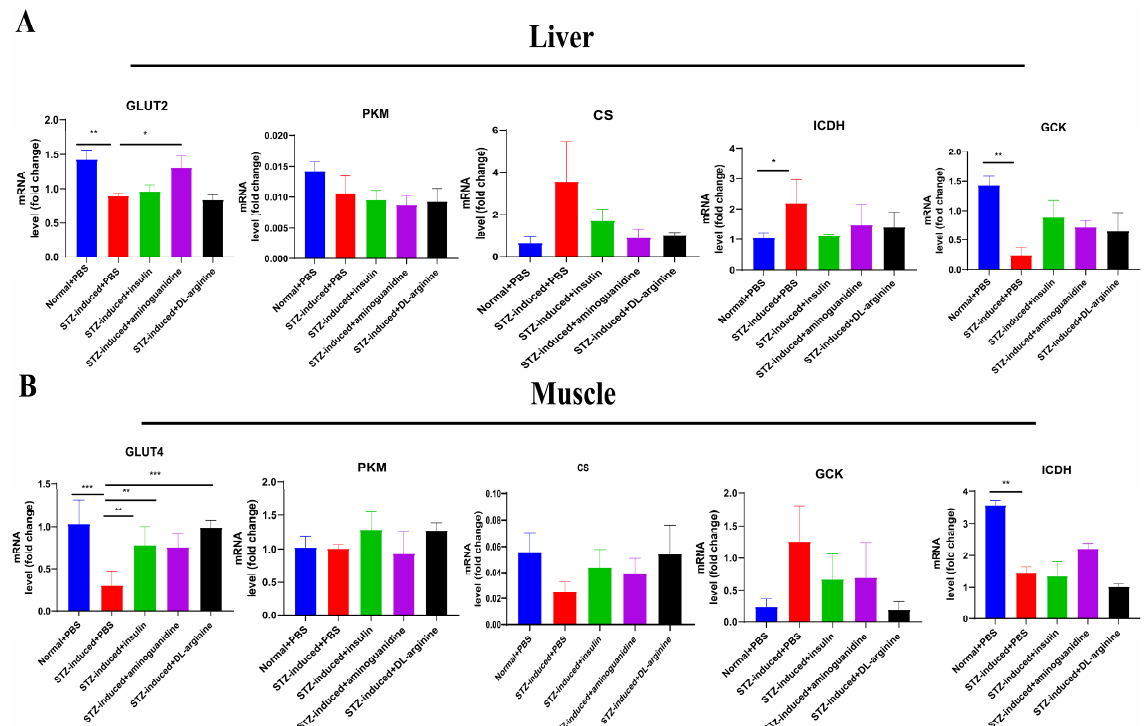
Figure 10. Effects of DL-arginine on the content of glucose metabolism-related enzymes ( GLUT2/4, PKM, CS, GCK, ICDH ) in the liver and muscle of rats. ( A ) Expression of glucose transporters 2 (GLUT2) , pyruvate kinase M ( PKM ), glucokinase ( GCK ), citrate synthase ( CS ), and isocitrate dehydrogenase ( ICDH ) mRNA in the liver was analyzed by quantitative RT-PCR. ( B ) Expression of GLUT4, PK, CS , and ICDH mRNA in muscle was analyzed by quantitative RT-PCR. All values of ( A , B ) are means ± SE; n = 3 per group, with * p < 0.05, ** p < 0.01, *** p < 0.001, determined by one-way ANOVA.